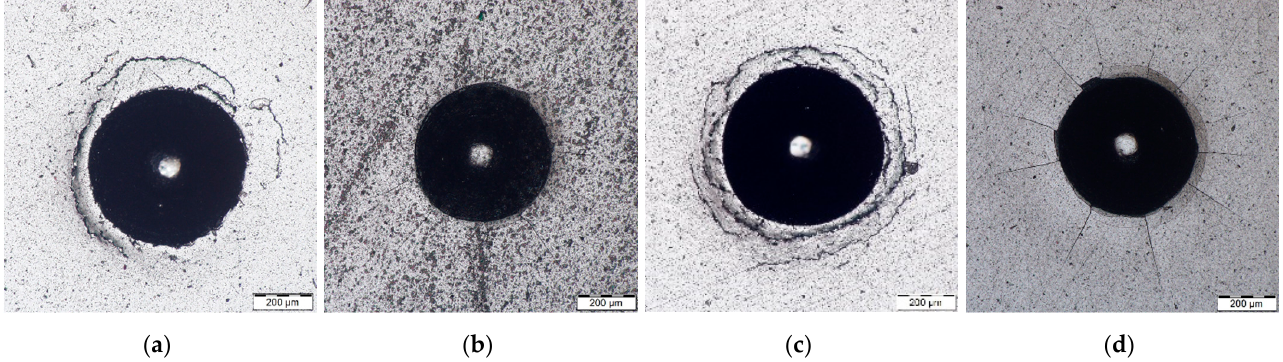
Figure 7. The optical micrograph of Rockwell indentation of the coatings on substrate steel H13 with magnification 250×: